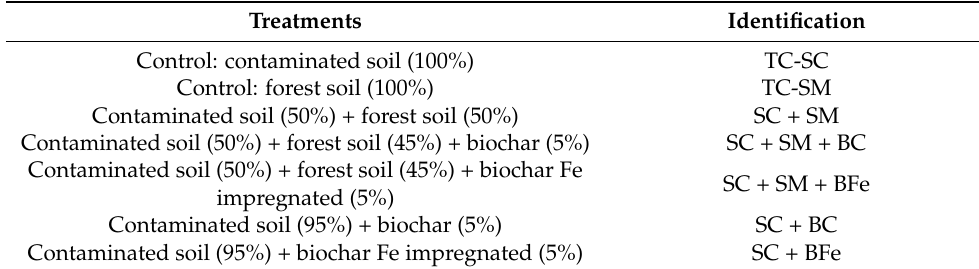
Table 1. Chemical properties of the soils used in the experiment. Sand Clay Silt a CEC b OM pH g kg − 1 cmol kg − 1 g kg − 1 H 2 O c SC 340.1 46.8 613.1 47.6 8.3 8.3 d SM 538 330 132 76.1 12.6 4.6